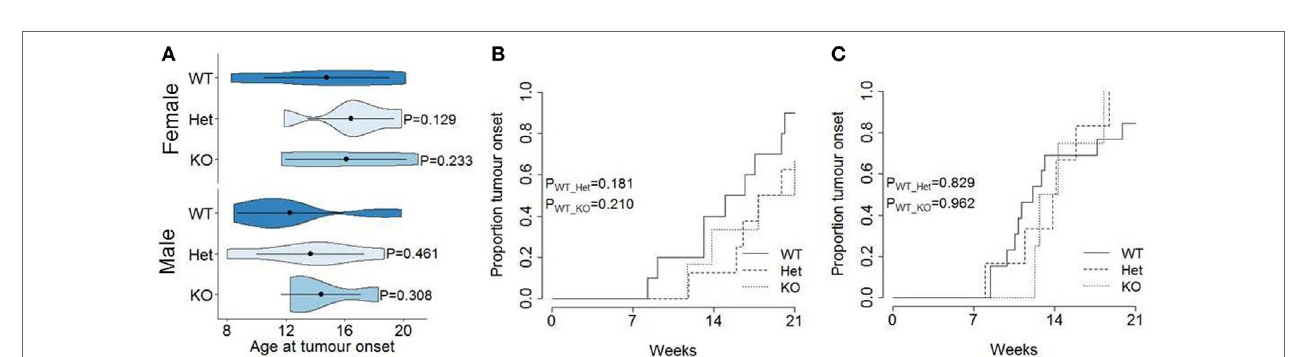
FigUre 3 | normal tumor onset in miR-342 knockout mice . TAg + , miR-342 + /0 TAg + , and miR-342 0/0 TAg + mice were monitored longitudinally by magnetic resonance imaging for tumor presence. (a) Violin plots showing the mean, standard deviation, and kernel probability density of age at tumor onset. Cumulative incidence of pancreatic cancer in (B) female ( n = 10, 8, 6) and (c) male ( n = 13, 6, 4)